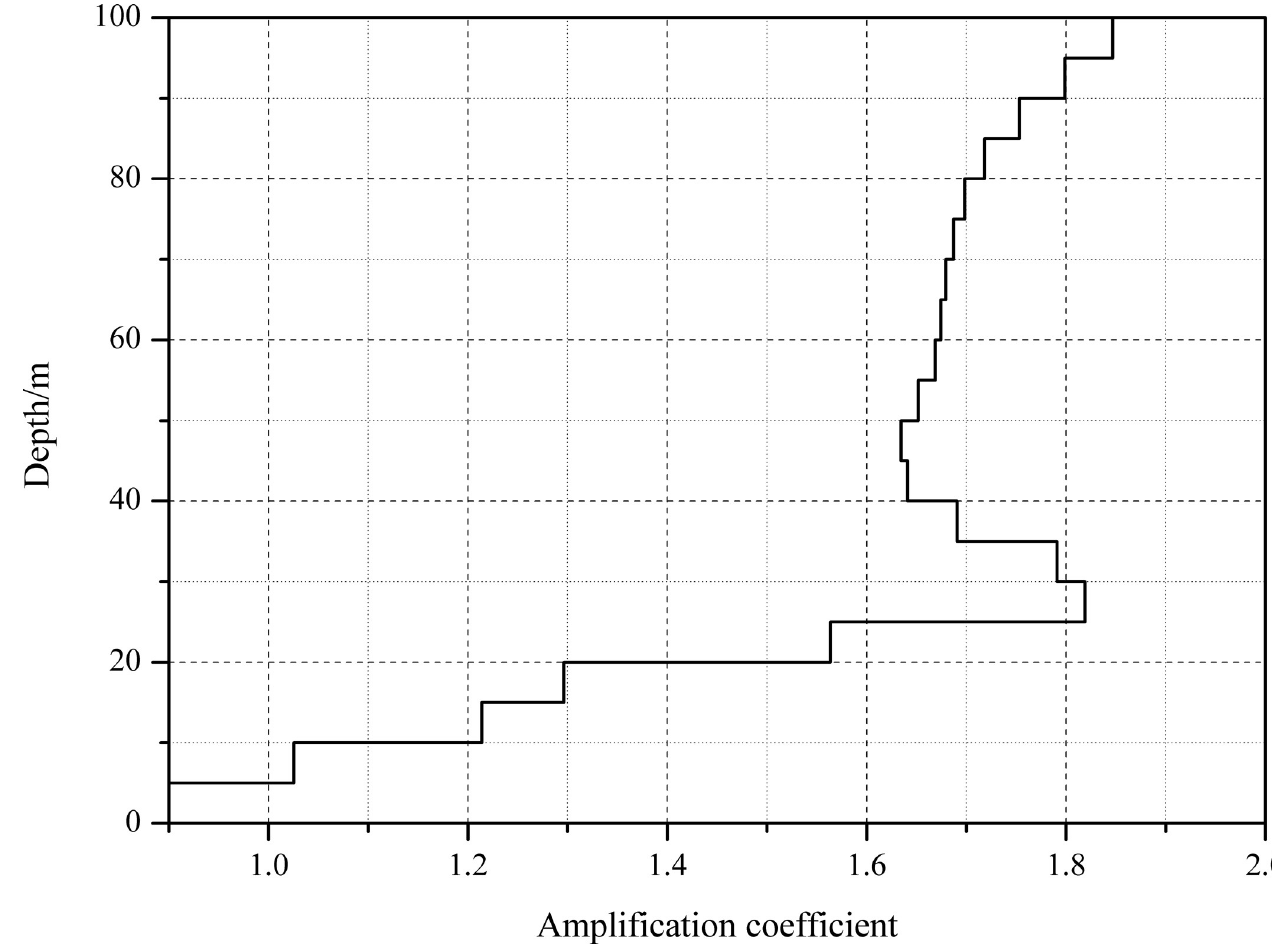
Fig 5. The distribution of the PGA amplification